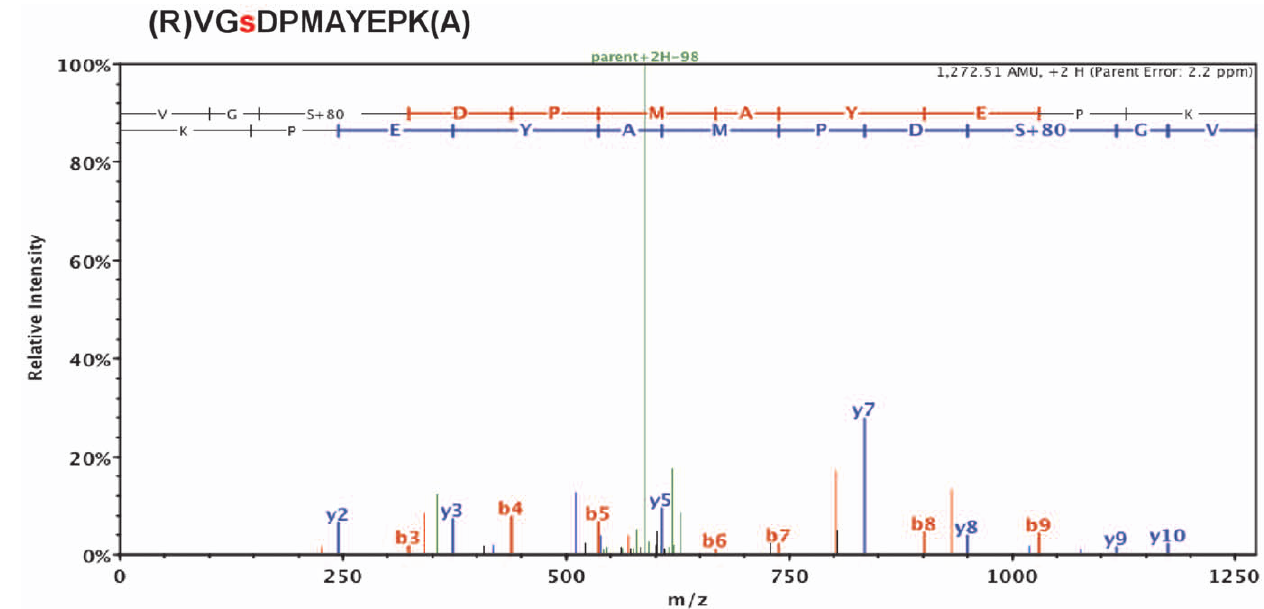
Figure 5. Ion Trap MS/MS spectrum of a fragmented peptide containing phosphorylated serine 711 of at NHE1. NHE1 was immunoprecipitated from atRBC membranes, SDS-PAGE purified and in-gel digested with trypsin. The resulting peptides were extracted an analyzed by LC-MS/MS. MS/MS spectra were generated by collision-induced dissociation of individual peptides, which preferentially fragments peptides at peptide bonds to generate N-terminal (b ions) and C-terminal (y ions) fragments with characteristic charge/mass (m/z) ratios identifying the amino acid composition of the collection of fragments. In this representative spectrum, the (2 + ) y ions are labeled in red and positioned above the b ions labeled in blue. Phosphorylation of serine 711 is shown as a gain of 80-kDa corresponding to H 3 PO 4 . MS/MS spectra identifying other sites of NHE1 phosphorylation are on file in the Tranche database at ProteomeCommons.org (see Methods).